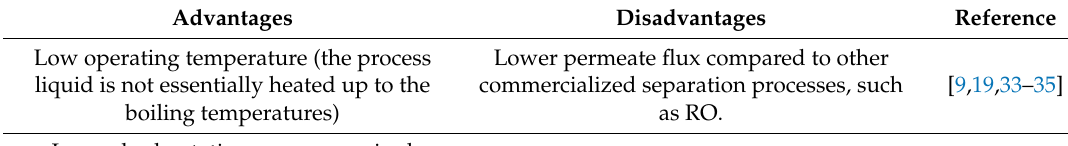
Table 2. A comprehensive overview of the positive and negative points of the MD process. Advantages Disadvantages